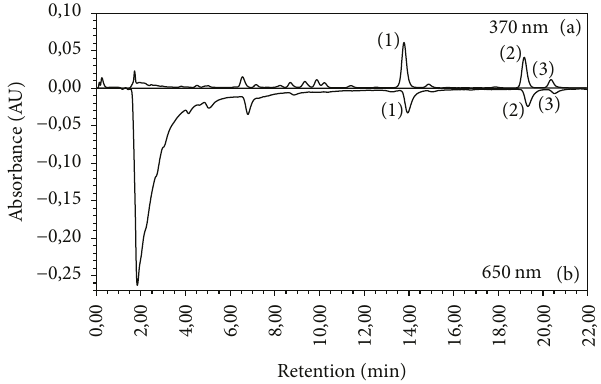
Figure 1: Combined chromatograms of Ginkgo biloba leaf extracts: chromatographic elution (a) and postcolumn reaction with ABTS (b) reagent. The numbers refer to the following identified com- pounds: ( 1 ) quercetin, ( 2 ) kaempferol, and ( 3 )